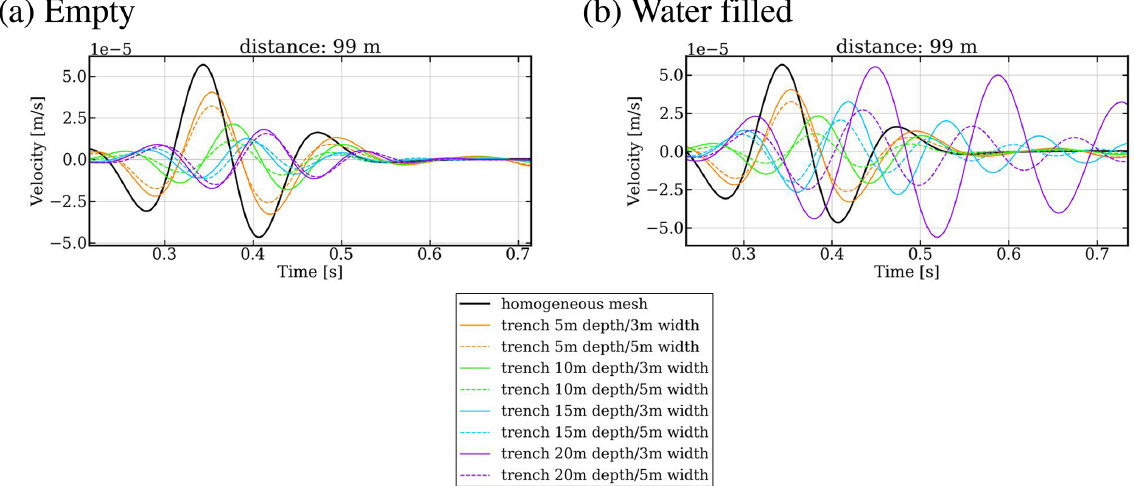
Figure 4. (a) Simulation results for cavities as empty half-circular trenches (see Fig. 3) using a Ricker source time function centered at 5Hz. Different sizes of cavities are shown by different colors (see legend), and the waveform of the model without cavity is shown as a black solid line. (b) Same as (a) but for cavities filled with